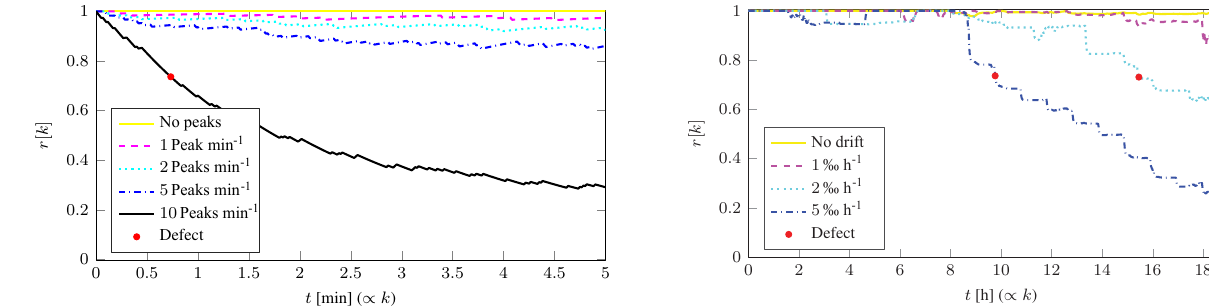
Figure 12. Reliability and detected defects for drift sensor faults. Results are shown for drift rates between 1 and 5‰h − 1 . Detected defects are marked by a red dot.